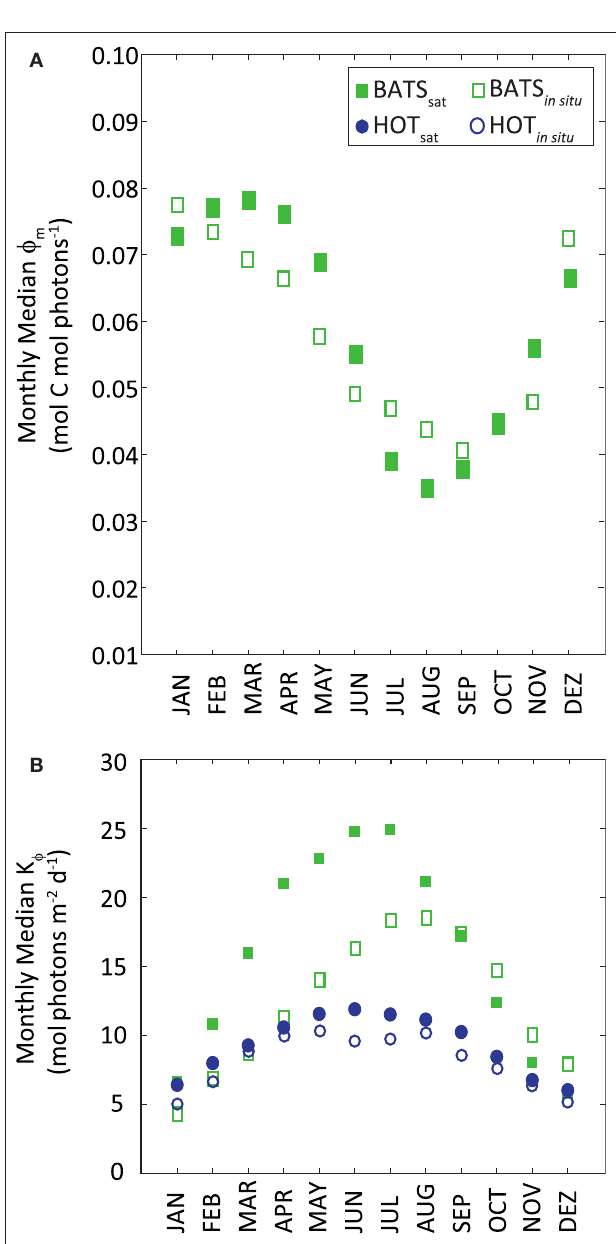
FIGURE 6 | (A) Monthly median φ m as a function of monthly SST and (B) monthly median K φ as a function of PAR. Station HOT is displayed as blue circles and BATS as green squares. Filled markers refer to parameters obtained from satellite measurements; empty markers correspond to the same parameters from in situ